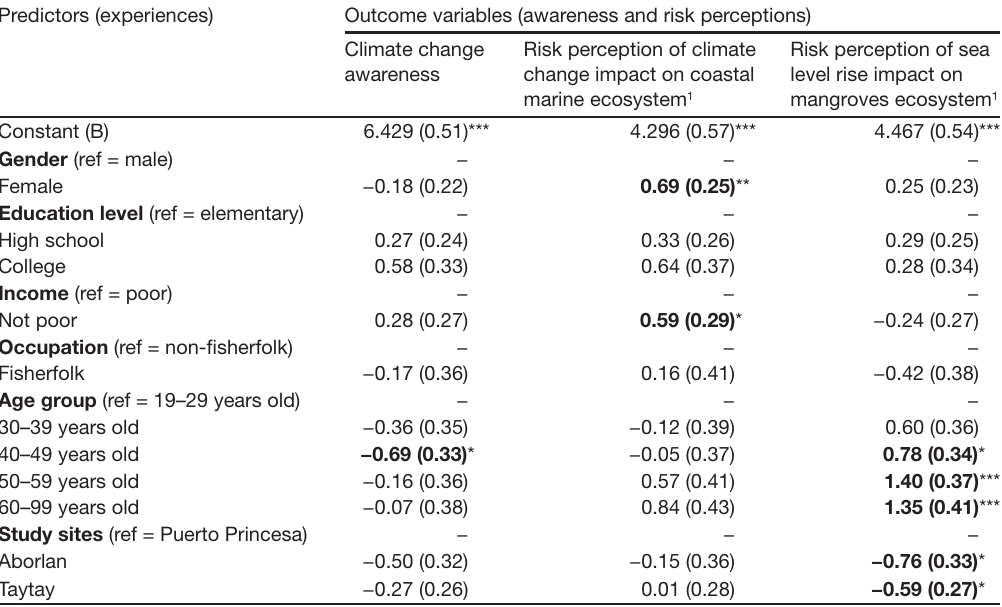
Proportion of participants who perceive low, moderate or high impacts to coral reefs and sea grass beds from different drivers. The response options provided to the participants is a bipolar rating scale: 1 = very low to 7 = very high. Low category included scores 1–3, moderate category score 4 and high category scores 5–7 (n = 291). (Source: Authors, 2022.)